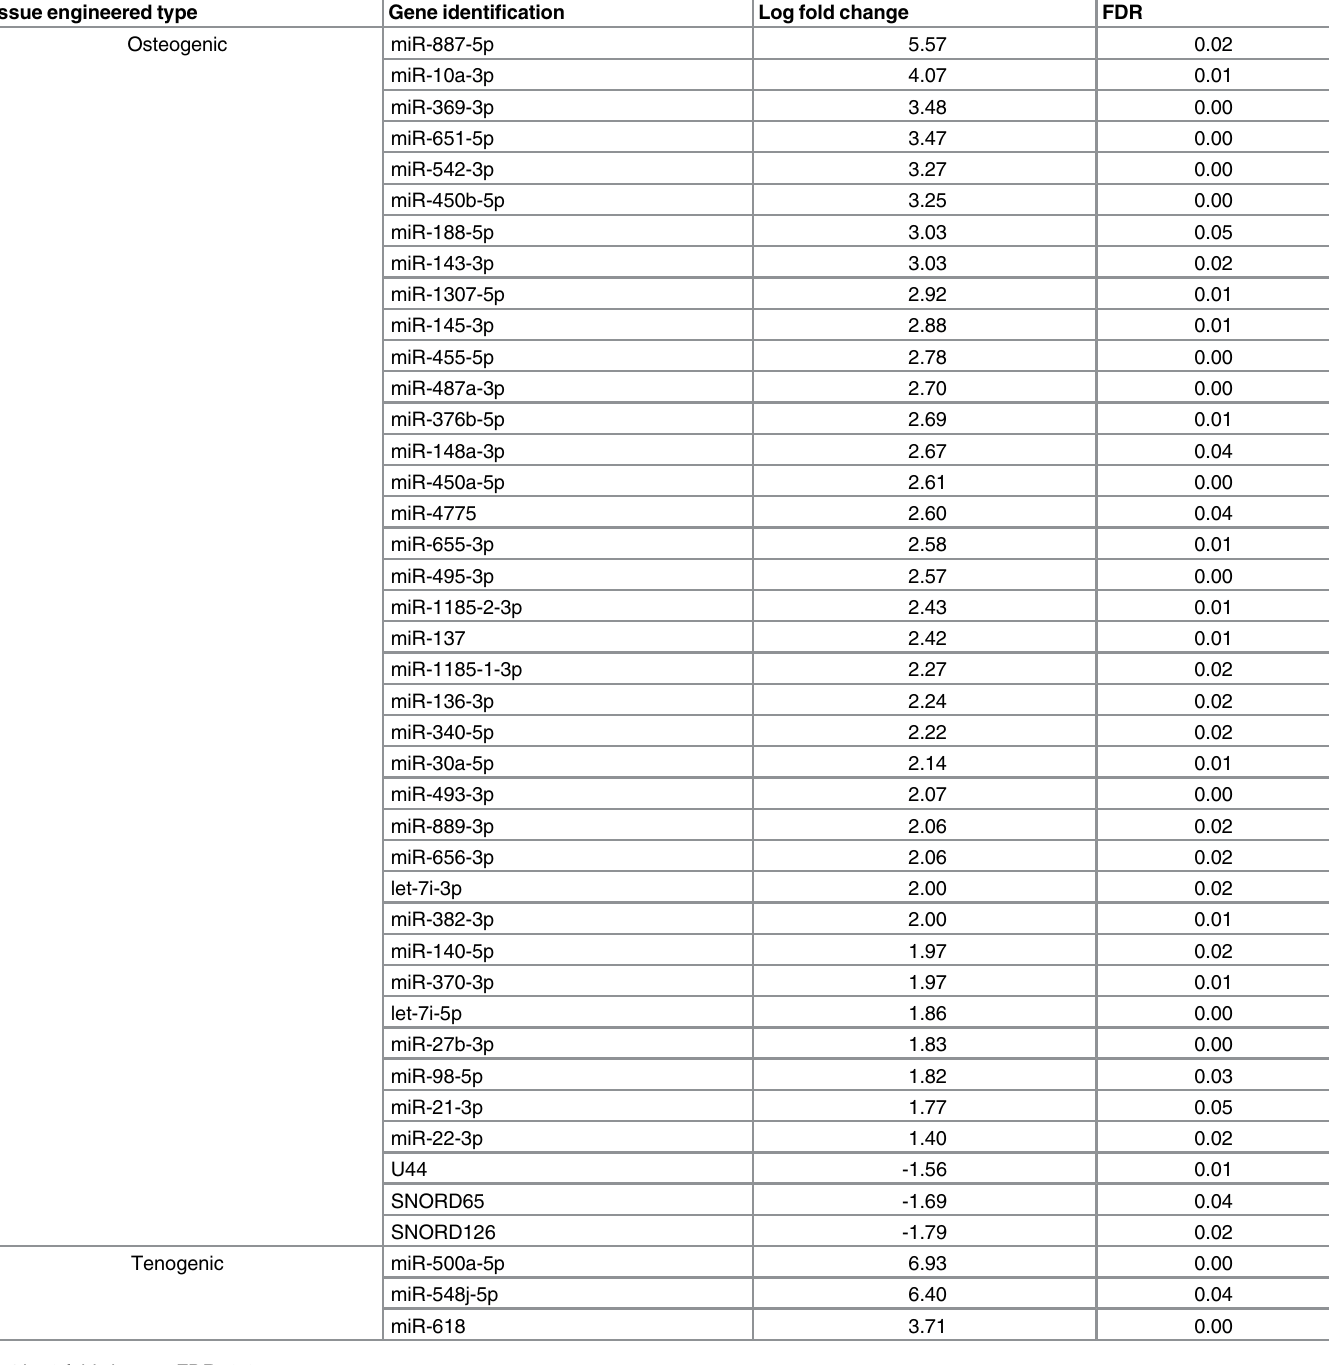
Table 3. Age-related differentially expressed small RNAs in osteogenic and tenogenic engineered